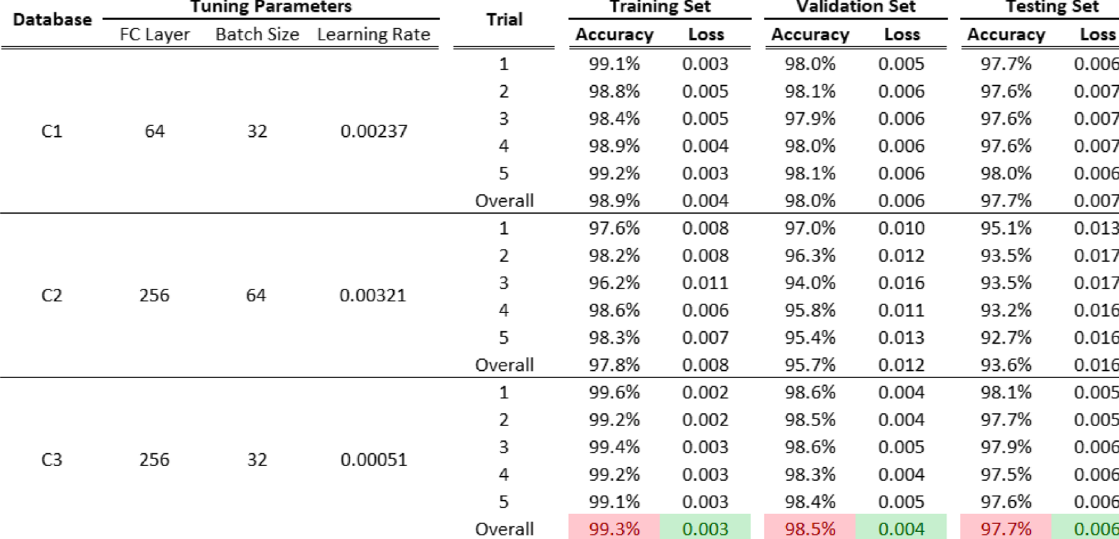
Table 8 Overall accuracy and loss of three cases with the optimally-tuned